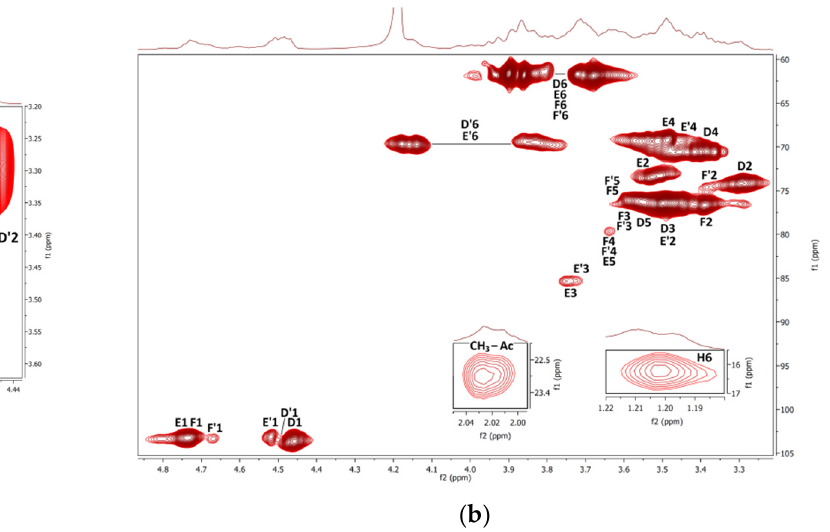
Figure 7. 1 H, 1 H COSY ( a ) and 1 H, 13 C HMQC ( b ) NMR spectra of the fraction F2.